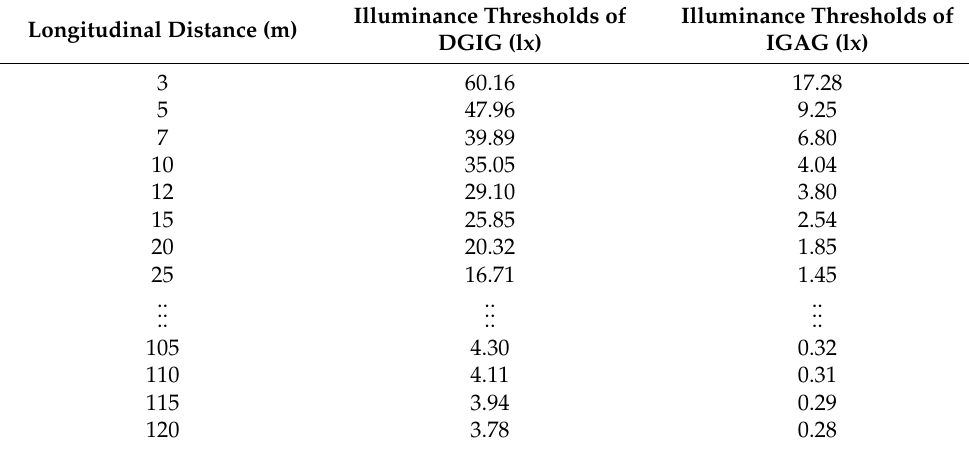
Table 6. Illuminance threshold values of DGIG and IGAG for different longitudinal distances (0–120